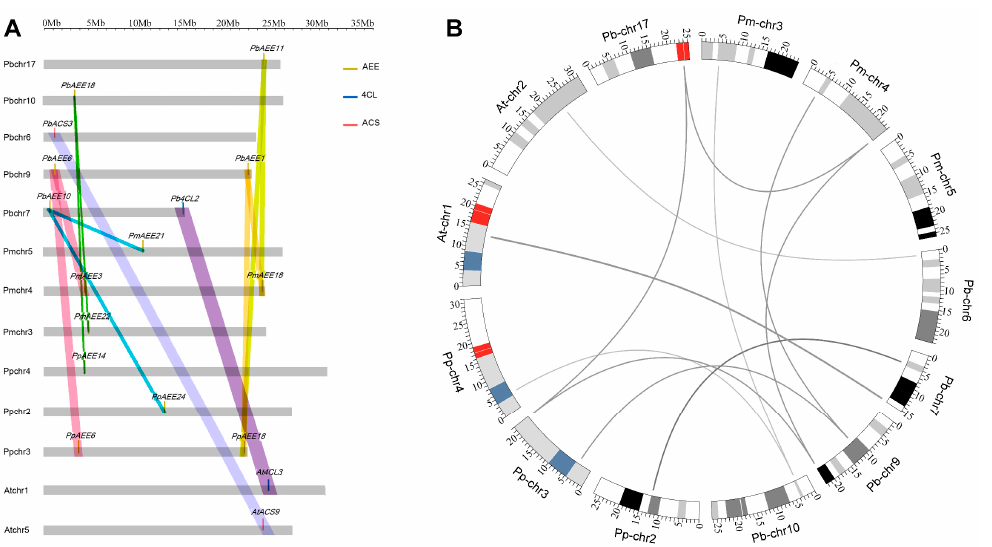
Figure 3. Collinearity analysis of 4CL-related regions among pear, rice, Arabidopsis , apple, peach, and yangmei. To identify the species of origin for each chromosome, a species identifier is included before the chromosome name: At, Arabidopsis thaliana ; Os, Oryza sativa ; Pb, Pyrus bretschneideri ; Pp, Prunus persica ; and Pm, Prunus mume . Different colored bars connect collinear regions between Pyrus bretschneideri and the other plant species.